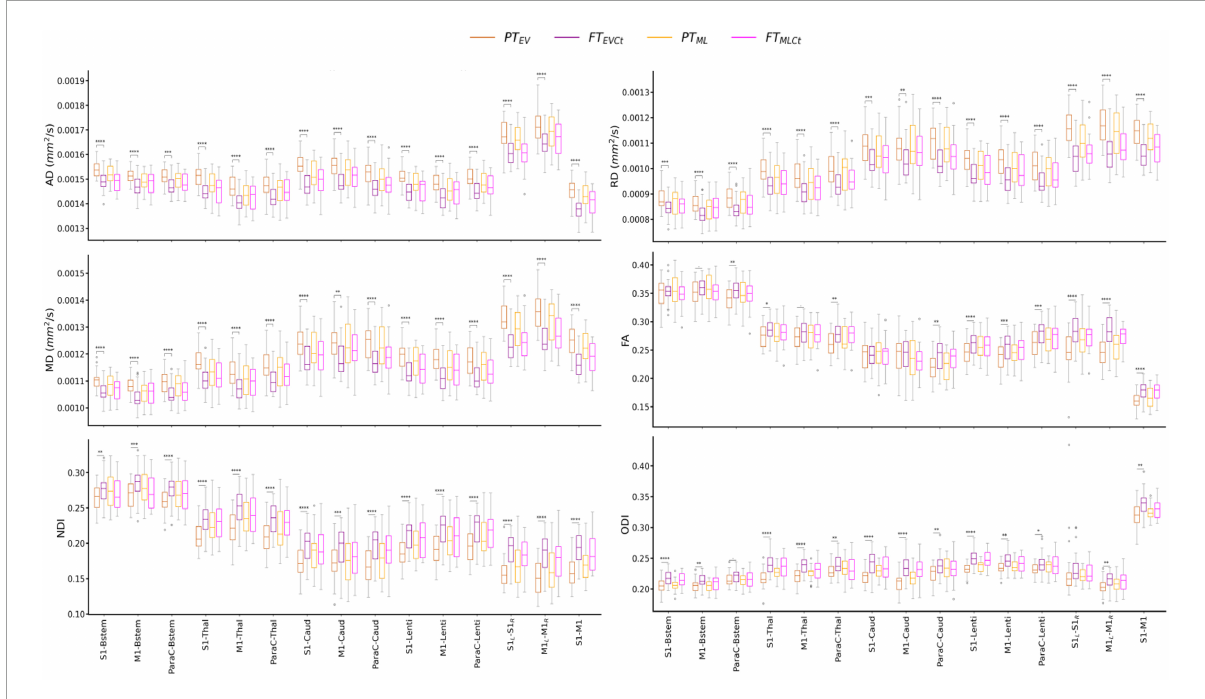
FIGURE3 Diffusion metrics across tracts and cohort subgroups: extreme to very preterm group (PT EV , dark orange) compared to paired full-term controls (FT EVCt , dark purple), and moderate to late preterm group (PT ML , light orange) compared to paired controls (FT MLCt , light purple). Significances are results of the tract-specific paired t -tests between paired groups, corrected for multiple comparisons. Only the comparisons between PT EV – FT EVCt reached significance. Refer to Figure 1 legend for abbreviations and to Table 1 for p -value